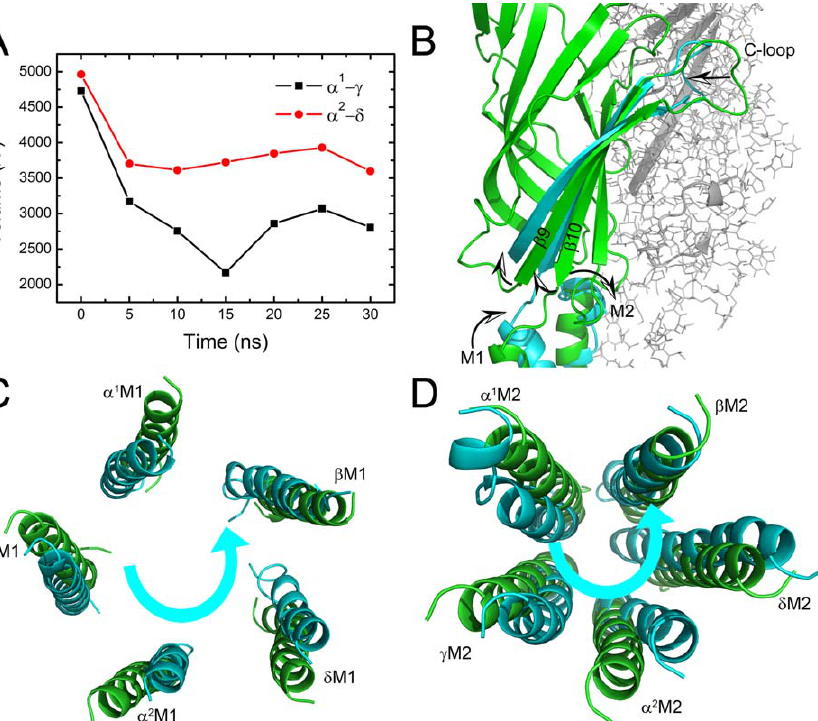
Figure 2. Collective Motions of the C-Loops, M1, and M2 Helices (A) The time-dependence of the volumes of ACh binding pockets. Black and red curves represent type-I ( a 1 - c ) and type-II ( a 2 - d ) pockets, respectively. (B) The motion tendencies of C-loops, M1, and M2 reflected by the superposition of subunit a 1 at the beginning (green) and after 30 ns simulation (cyan). The picture is displayed parallel to the pore axis. (C–D) The anticlockwise motions of the M1 and M2 helices. The superpositions are based on the centers of mass of the five M1 and M2 helices, respectively, and the pictures are viewed from the synaptic cleft.